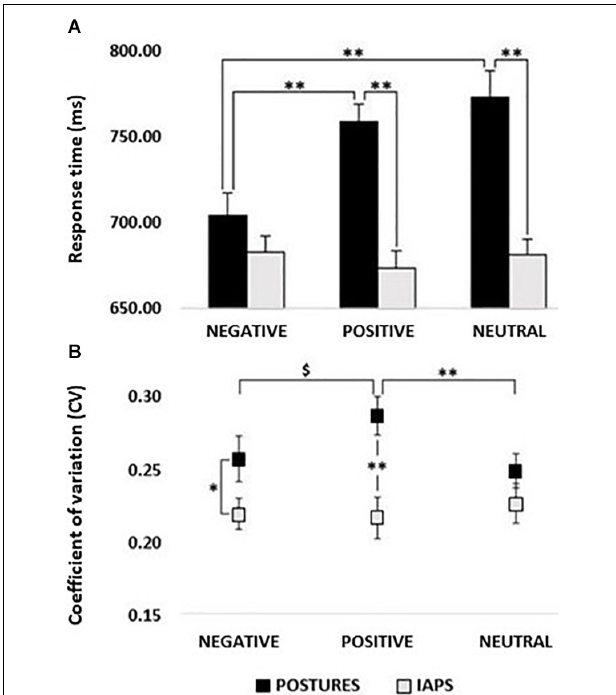
FIGURE 2 | (A) Response times (RTs). Histogram showing a comparison between RTs recorded in postures and IAPS trials. Significant differences were found between negative and positive and negative and neutral for postures, as well as between positive and neutral in the comparison between postures and IAPS, but not for negative. No differences were retrievable between emotions in the IAPS trial. RT values in milliseconds (ms) are reported in the y -axis, and emotions are reported on the x -axis with black bars for postures and gray bars for IAPS. (B) Coefficient of variation; postures vs IAPS. Positive’s CV in the posture trial was significantly higher than the one computed for neutral and showed a trend in the comparison with negative, while no differences were found for IAPS. Postures’ negative and positive CVs were higher in the comparison with the variation retrieved in the IAPS trials. CV ranges from 0 to 1; on the y -axis, it is possible to observe a partial scale that focuses on the range of the CV found in the experiment. Emotions are reported on the x -axis with a straight line for postures and a dotted line for IAPS. Legend: ∗ = p < 0.05, ∗∗ = p < 0.01, $ = p >